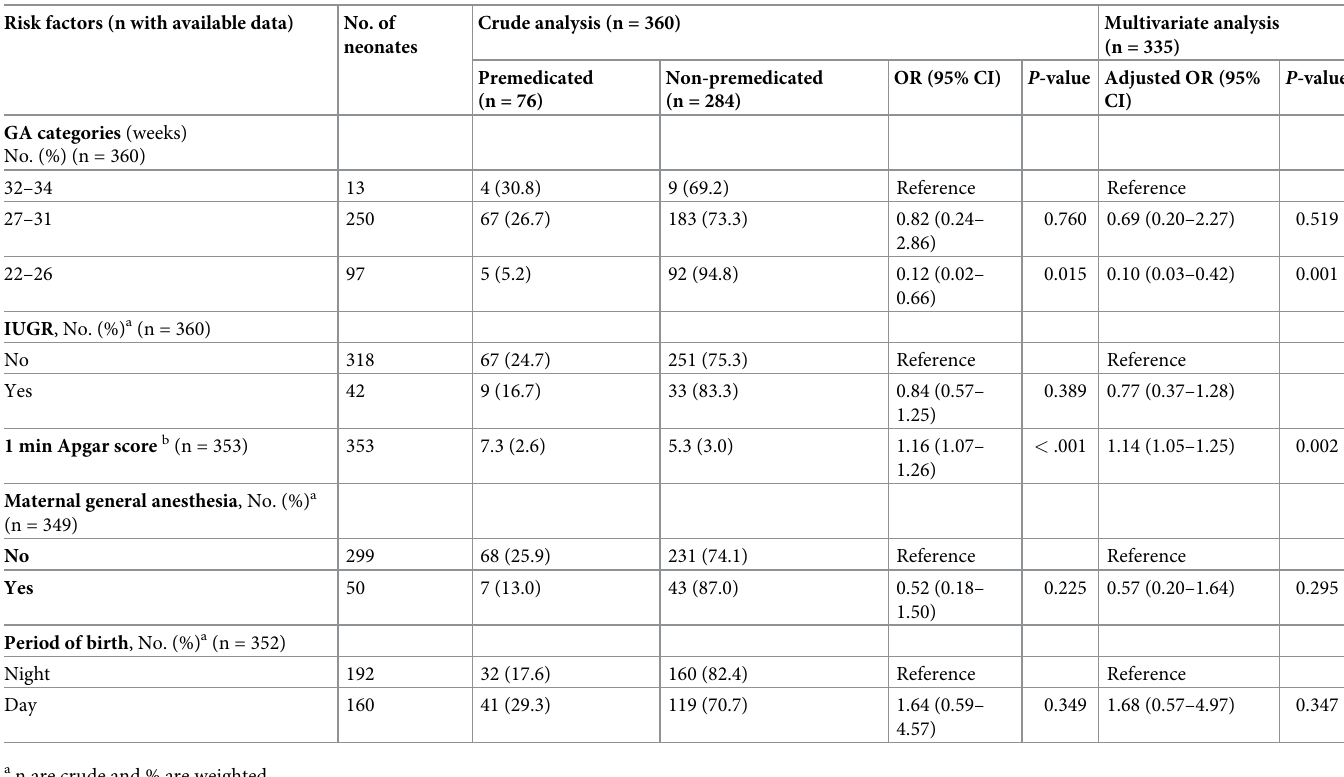
Table 4. Multivariate analysis of neonatal factors associated with a premedication across centers that performed at least one premedication in the DR. Risk factors (n with available